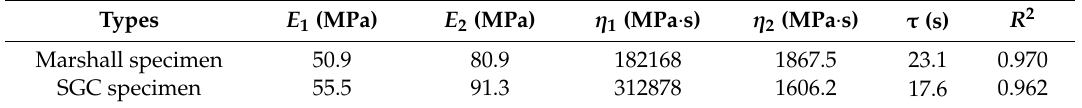
Figure 12. Schematic representation of Burgers and modified Burgers models. Table 5. Fitting parameters of Burgers model.